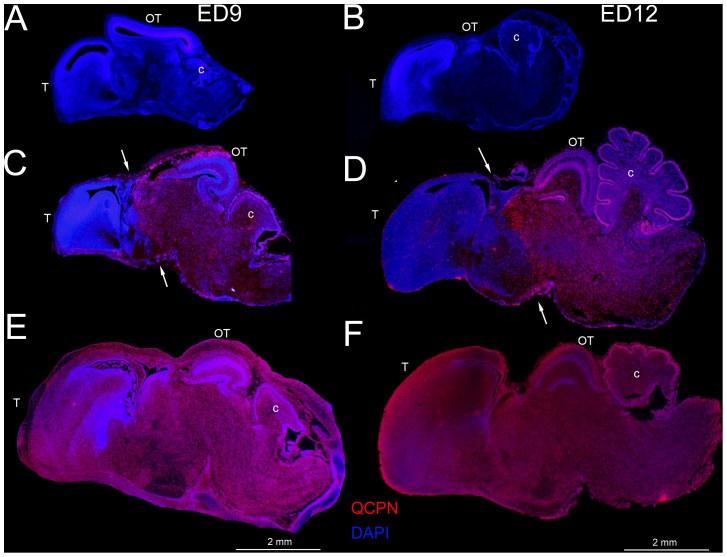
Sagittal sections of zebra finch, chimera and quail embryonic brain stained with the QCPN antibody.QCPN is red and DAPI is blue. (A and B) Stained brain sections of zebra finch at ED9 (left column) and ED12 (right column). (C and D) Stained chimera sections at both ages. White arrows point to the fused boundary of zebra finch graft and quail host between the thalamus and midbrain. (E and F) Stained quail brain sections at both ages.